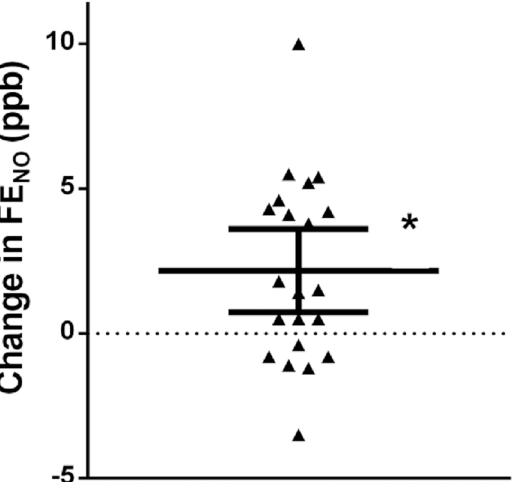
Fig 2. Plot showing the individual values and the mean with 95% confidence interval post- bronchodilator changes in FE NO 50, ppb. ( * P = 0.005 for the change in FE NO